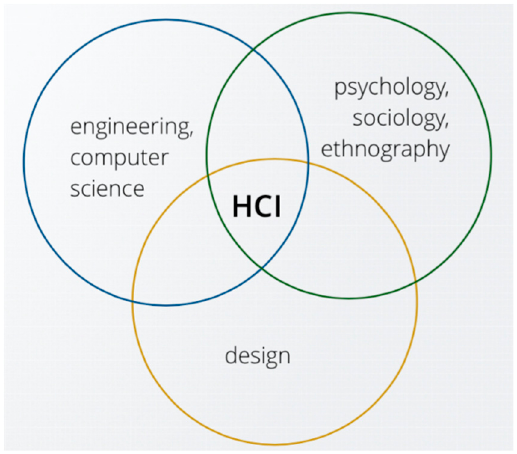
Figure 2. Parts of Human-Computer Interaction [7].